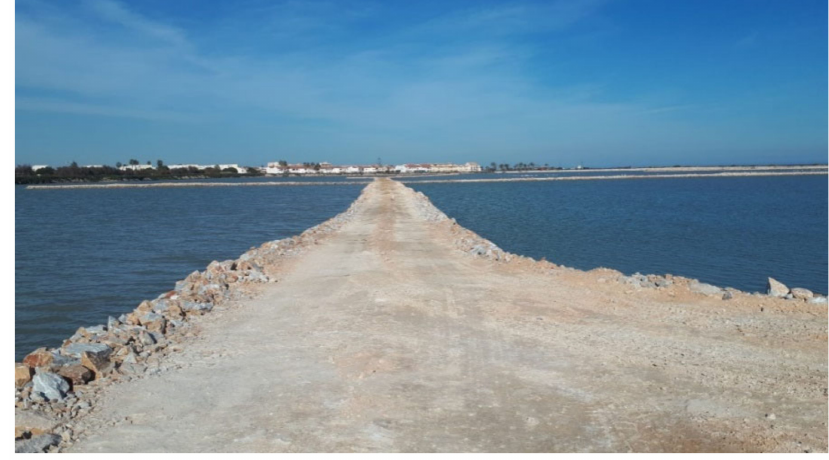
Figure 7. New sandy dikes separating salt ponds (Source: LIFE-SALINAS Project).